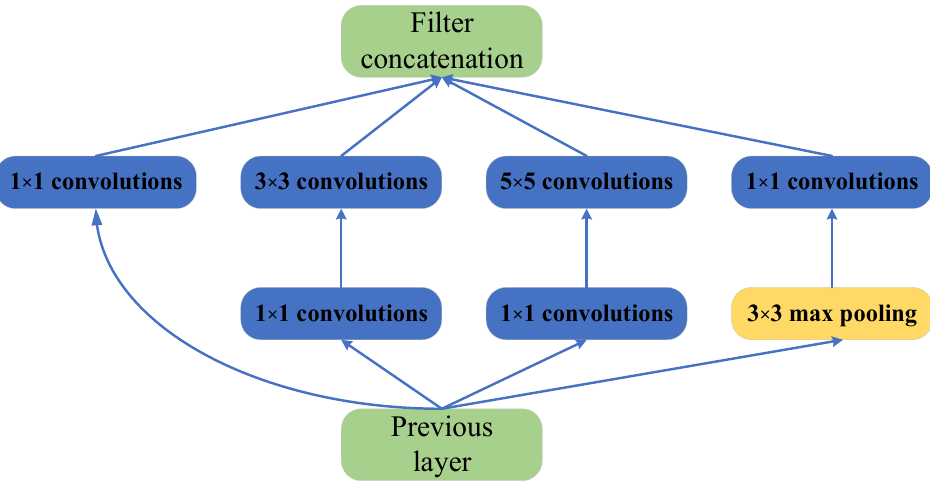
Figure 2. Inception architecture.